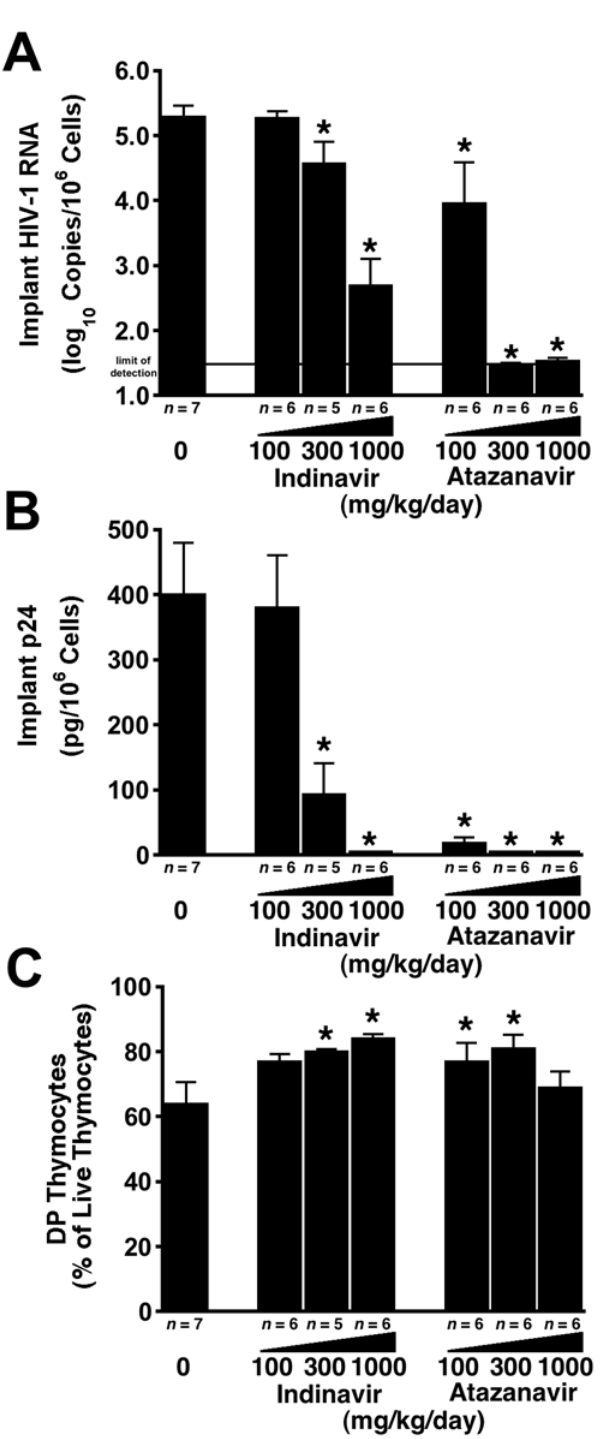
Figure 6. Atazanavir is more potent than indinavir against HIV-1 NL4- 3 in SCID-hu Thy/Liv mice. Mice were treated by twice-daily oral gavage with indinavir or atazanavir at 100, 300, and 1000 mg/kg per day beginning on day 2 1. Antiviral efficacy was assessed by determining HIV-1 RNA (A) and p24 (B), and thymocyte protection was assessed by percentage of DP thymocytes (C) (means 6 SEM). *p # 0.05, compared with untreated mice for the number of mice indicated under each bar.